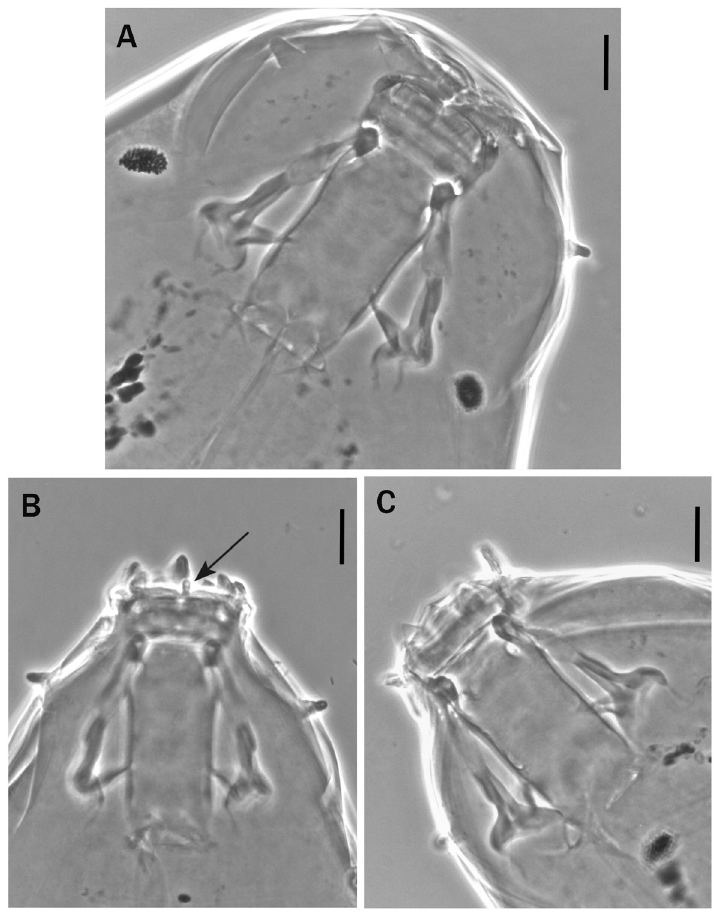
Fig. 17. Milnesium irenae sp. nov. A . Holotype, ♀ (slide No. UNLPam 1657-1). B . Paratype, ♀ (slide No. UNLPam 1599-3). C . Paratype, ♀ (slide No. UNLPam 1656-3). Cephalic region. A . Buccal tube and the noticeable development of the stylets, their furcae and supports. B . The reduced medio-ventral